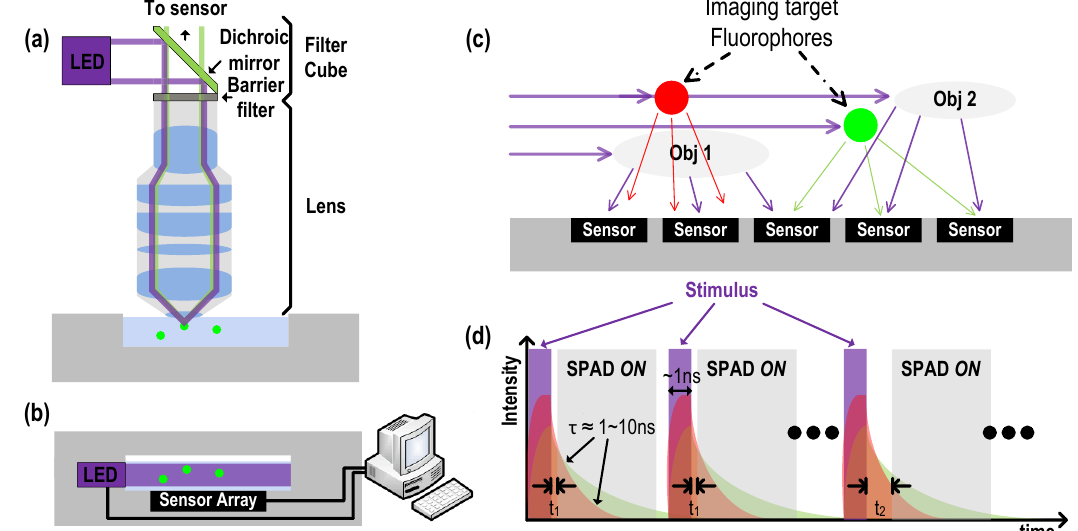
Figure 1. 3D imaging without lens and filter ( a ) conventional fluorescent imaging, ( b ) on-chip fluorescent imaging. ( c ) Stimulus light is illuminated in parallel to the sensor surface, the fluorescence emission and scattered from the imaging space (Obj1 and Obj2) reach the sensor surface. ( d ) Time-resolved fluorescent imaging for stimulus rejection and time-gated lifetime